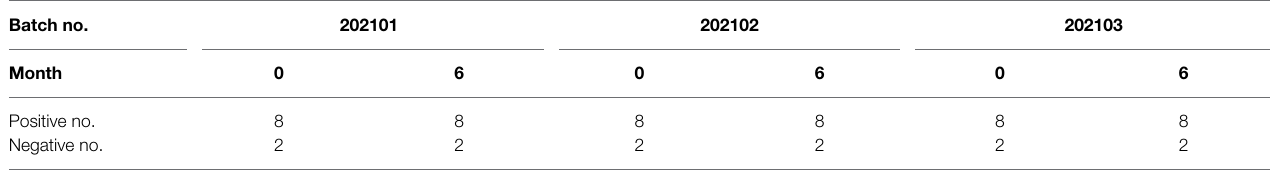
TABLE 2 | Assessment of the reproducibility and stability of the ICS. Batch